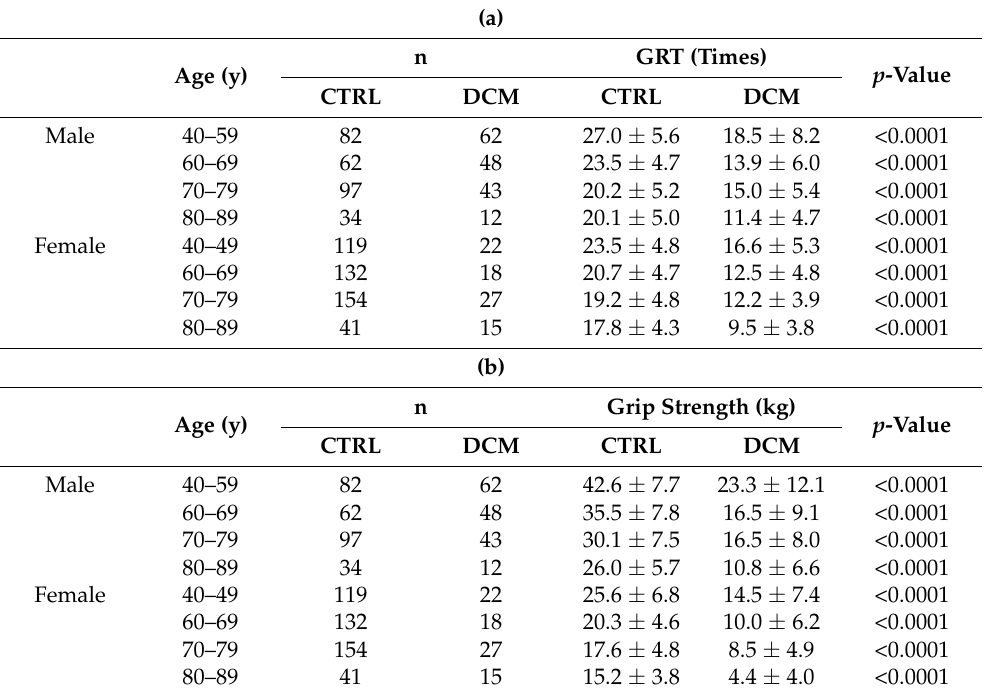
Table 1. ( a ) . Grip and release test by sex and age in both groups. ( b ). Grip strength by sex and age in both